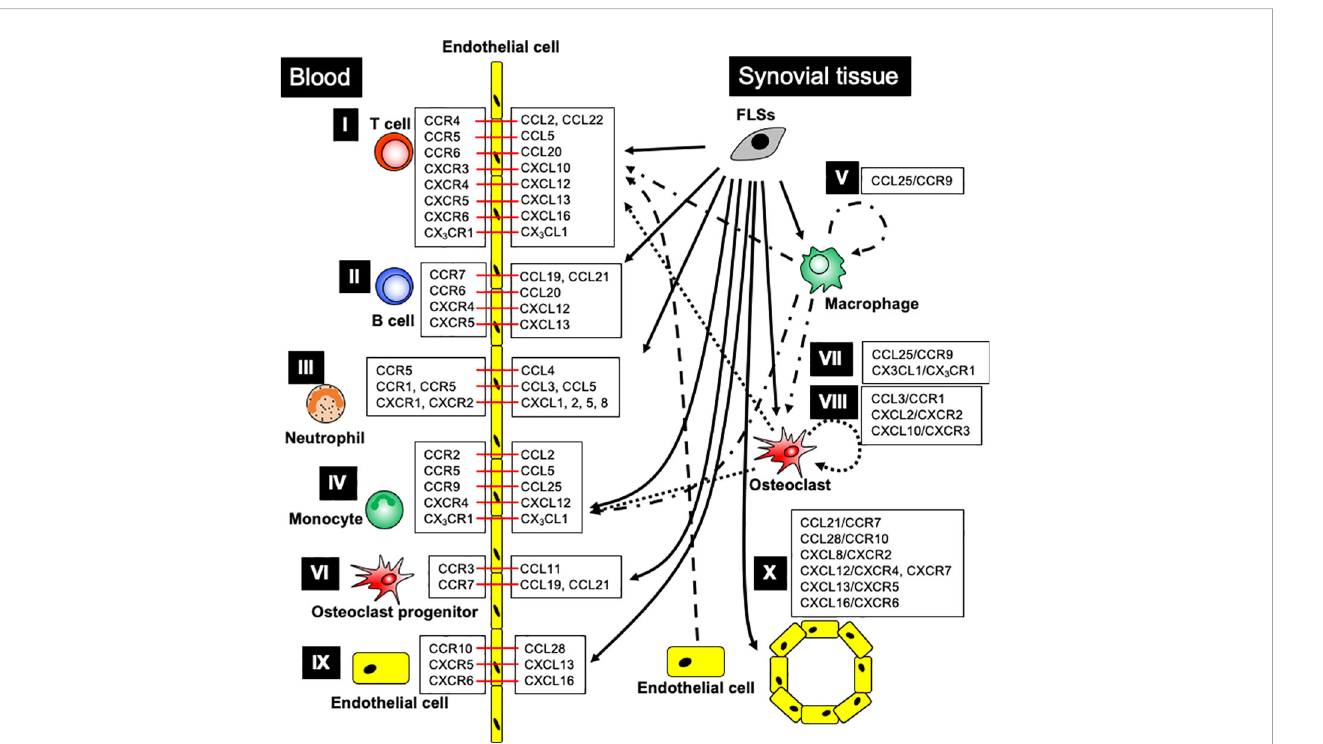
FIGURE 1 The major contribution of chemokine ligand-receptor interactions in RA patients. I. T cell recruitment: FLSs generate CCL2, CCL5, CCL20, CXCL13, and CXCL16; OCs produce CXCL10; ECs release CCL22; monocytes, macrophages, and OCs produce CX 3 CL1, promoting T cell recruitment into the arthritic joints through the indicated chemokine receptors. II. B cell recruitment: FLSs generate CCL19-21, CXCL12, and CXCL13, enhancing B cell recruitment into arthritic joints through the respective chemokine receptors. III. Neutrophil recruitment: FLSs generate CCL3-5, CXCL1, CXCL2, CXCL5, and CXCL8, leading to neutrophil recruitment into arthritic joints through the indicated chemokine receptors. IV. Monocyte recruitment: FLSs generate CCL2, CCL5, CCL25, and CXCL12; synovial macrophages produce CCL25 and CX 3 CL1; OCs produce CCL2, CCL5, and CX 3 CL1, promoting monocyte recruitment into the arthritic joints through chemokine receptor signaling. V. Synovial macrophage development: FLSs and macrophages generate CCL25, which promotes monocyte differentiation into macrophages. VI. Osteoclast progenitor recruitment: FLSs generate CCL11, CCL19, and CCL21, while ECs generate CCL19, leading to OCP recruitment into arthritic joints through the indicated chemokine receptors. VII. Osteoclast differentiation: FLSs and macrophages generate CCL25, and synovial macrophages and OCs generate CX 3 CL1, promoting osteoclast differentiation through chemokine receptors. VIII. Osteoclastogenesis: FLSs, T cells, and neutrophils generate CCL3; FLSs generate CXCL2; and OCs generate CXCL10, ensuring osteoclastogenesis through the indicated chemokine receptors. IX. Endothelial cell recruitment: FLSs generate CCL28, CXCL13, and CXCL16, stimulating endothelial cell recruitment into arthritic joints through the indicated chemokine receptors. X. Angiogenesis: FLSs generate CCL21, CCL28, CXCL8, CXCL12, CXCL13, and CXCL16, supporting angiogenesis through indicated chemokine receptors. Black arrow indicates chemokine production, and red bar shows chemokine ligand-receptor